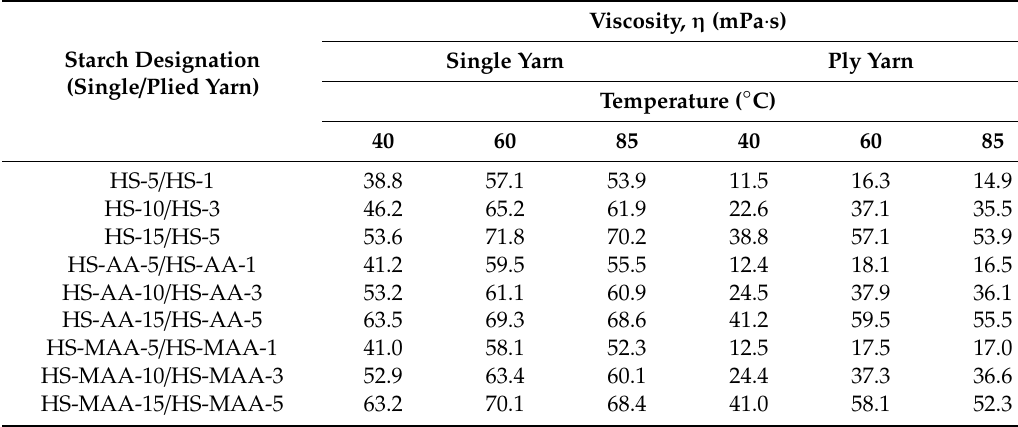
Table 5. Viscosity of the copolymer solution in di ff erent concentrations according to yarn types.